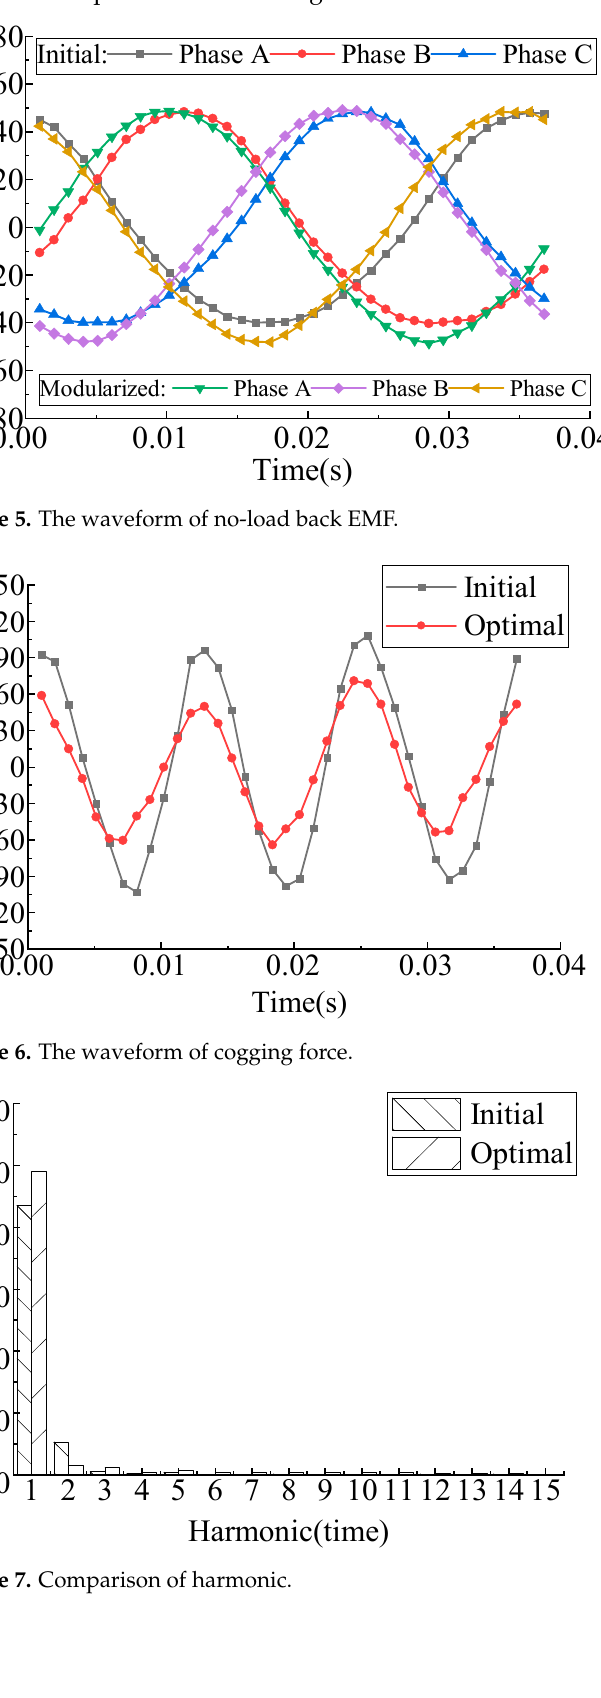
Figure 4. Modular principle verification diagram.